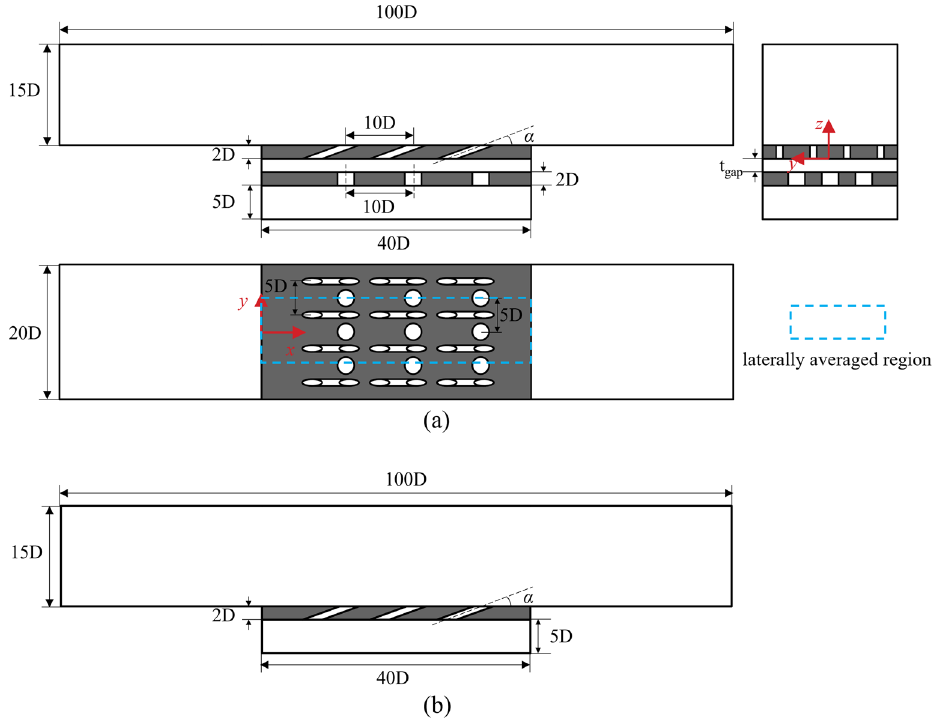
Figure 4. Geometric parameters of impingement-film hole model. ( a ) Impingement effusion model; ( b ) Film- hole model.